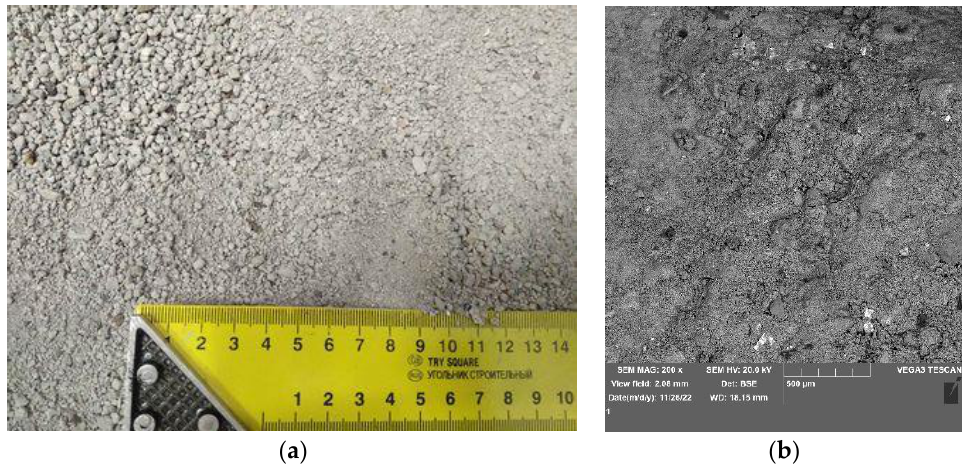
Figure 3. Photo ( a ) and SEM image ( b ) of the MSWI slag used for the